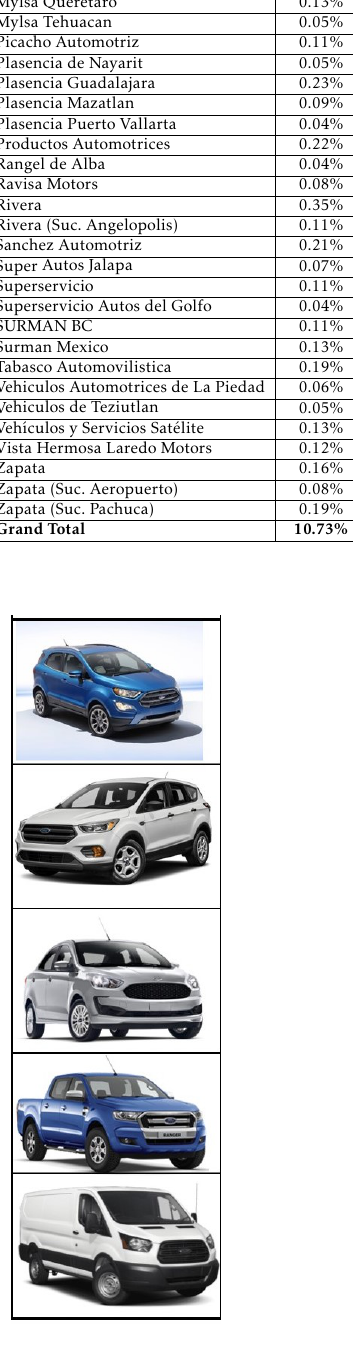
Figure 5. Products analyzed (automobiles)